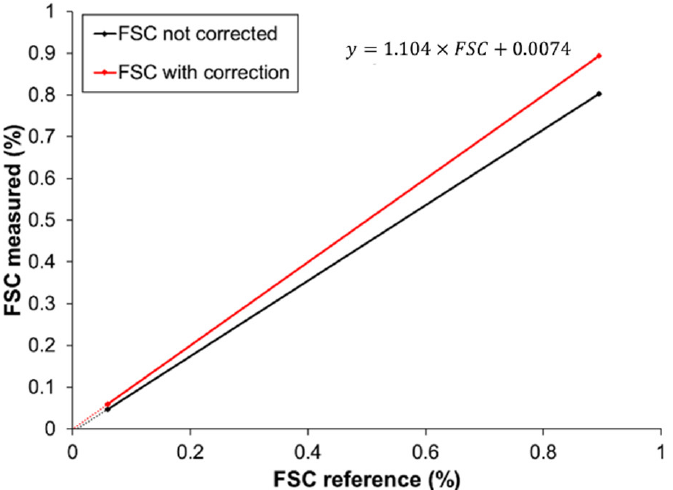
Figure 6. Calculation of the average slope and offset correction for the FSC measurements for 2020 ( upper ) and 2021 ( middle ) and the combined period from 2020–2021 ( lower ).